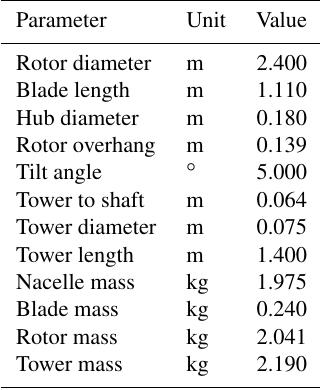
Table 1. Key parameters of the wind turbine